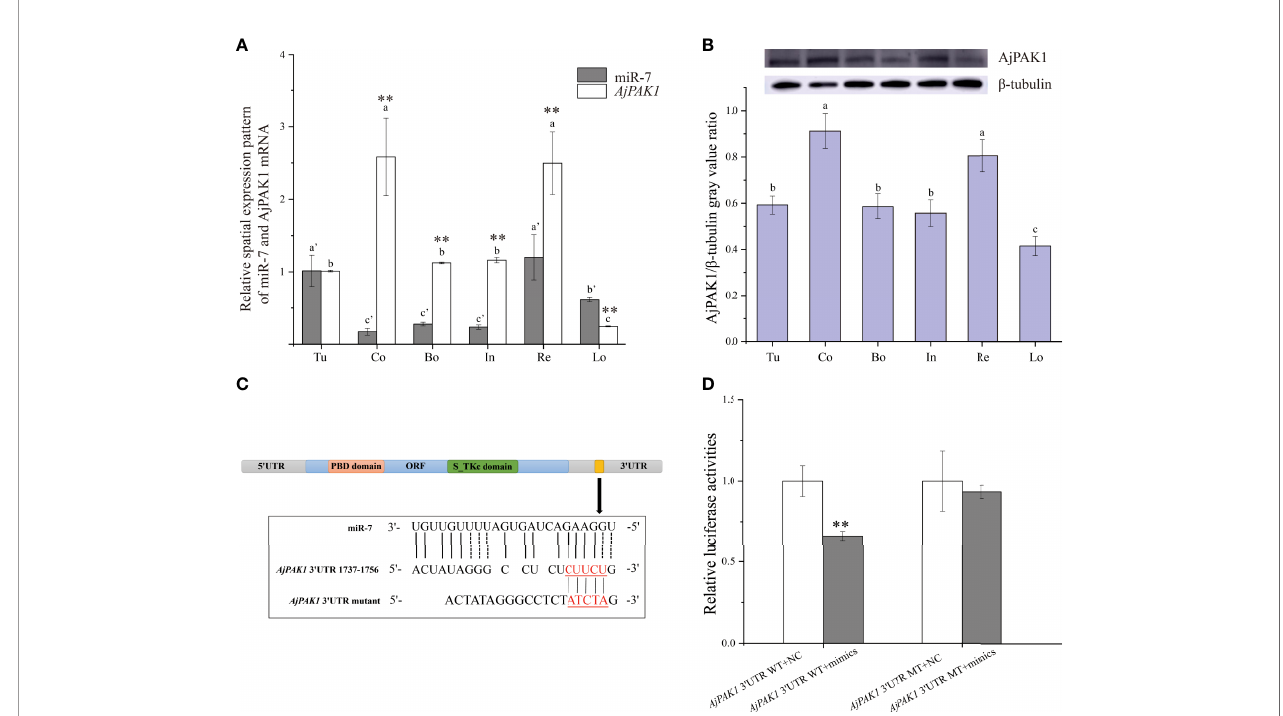
FIGURE 1 | Spatial expression patterns of miR-7 and AjPAK1 (mRNA and protein) in Apostichopus japonicus and identi fi cation of miR-7 binding sites in the 3 ’ UTR of AjPAK1 . (A) Relative spatial expression patterns of miR-7 and AjPAK1 mRNA. (B) Relative spatial expression pattern of AjPAK1 protein. (C) The predicted target site of miR-7 was found in the 3 ’ UTR of AjPAK1. (D) Analysis of relative luciferase activities. u, tube foot; Co, coelomocytes; Bo, body wall; In, intestine; Re, respiratory tree; Lo, longitudinal muscle.. ** represents an extremely signi fi cant difference ( P < 0.01) between AjPAK1 mRNA and miR-7 in the same tissue or between AjPAK1 3 ’ UTR WT + NC and AjPAK1 3 ’ UTR WT + mimics. Different lower-case letters (e.g., a or a ’ ) indicate signi fi cant differences between different tissues ( P <